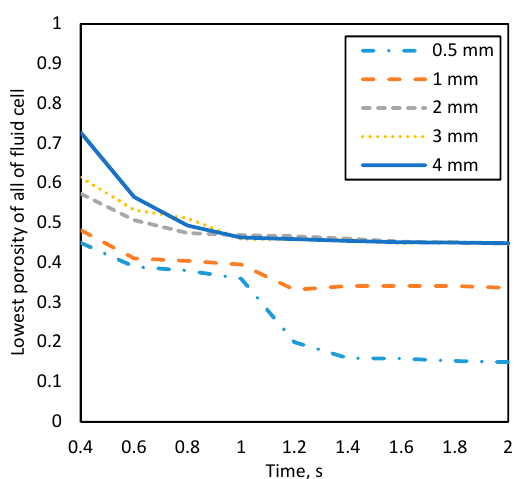
Figure 7. The lowest porosity of all of the fluid mesh cells at different simulation moment.